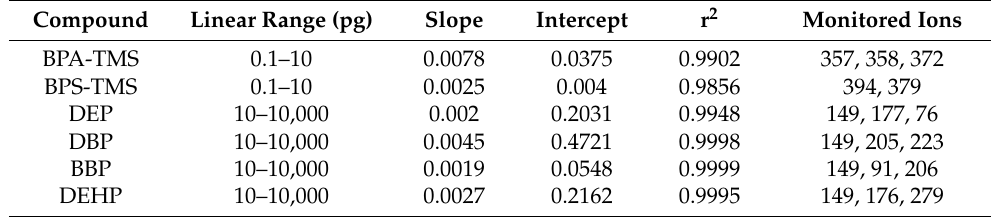
Table 2. Quantitative analysis